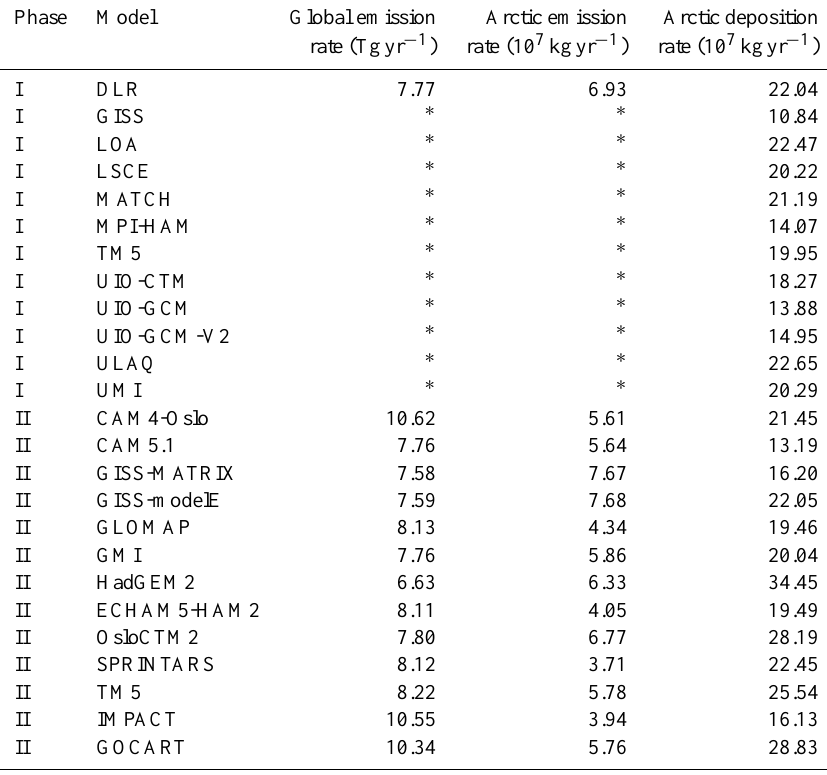
Table 3. Annual mean BC emission and deposition fluxes for the globe and Arctic (60 ◦ N to 90 ◦